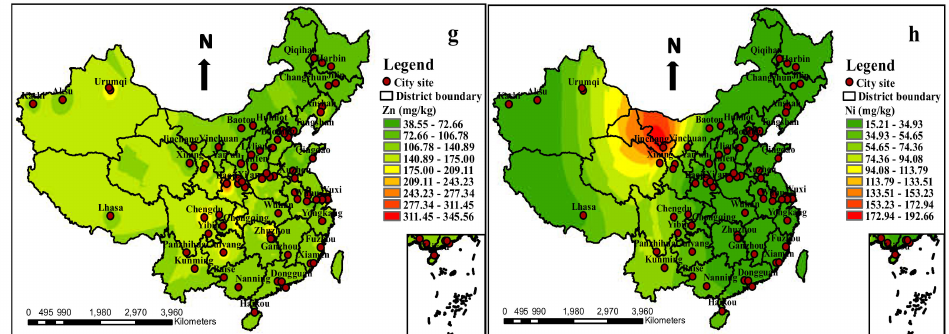
Figure 2. The spatial distribution of heavy metal contents in urban soils around China. ( a ): The spatial distribution of As contents in urban soils around China. ( b ): The spatial distribution of Cd contents in urban soils around China. ( c ): The spatial distribution of Cr contents in urban soils around China. ( d) : The spatial distribution of Hg contents in urban soils around China. ( e ): The spatial distribution of Pb contents in urban soils around China. ( f ): The spatial distribution of Cu contents in urban soils around China. ( g ): The spatial distribution of Zn contents in urban soils around China. ( h ): The spatial distribution of Ni contents in urban soils around